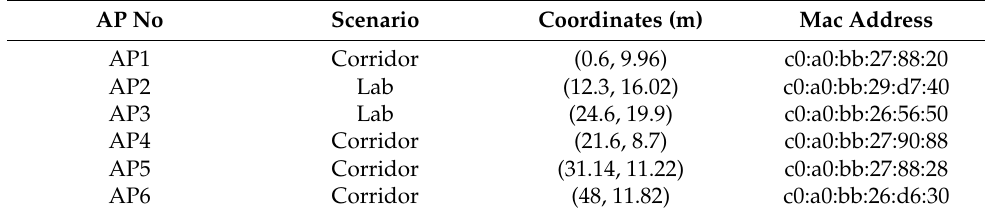
Figure 2. Test Bed. Corridor, office, lobbies environment scenarios.